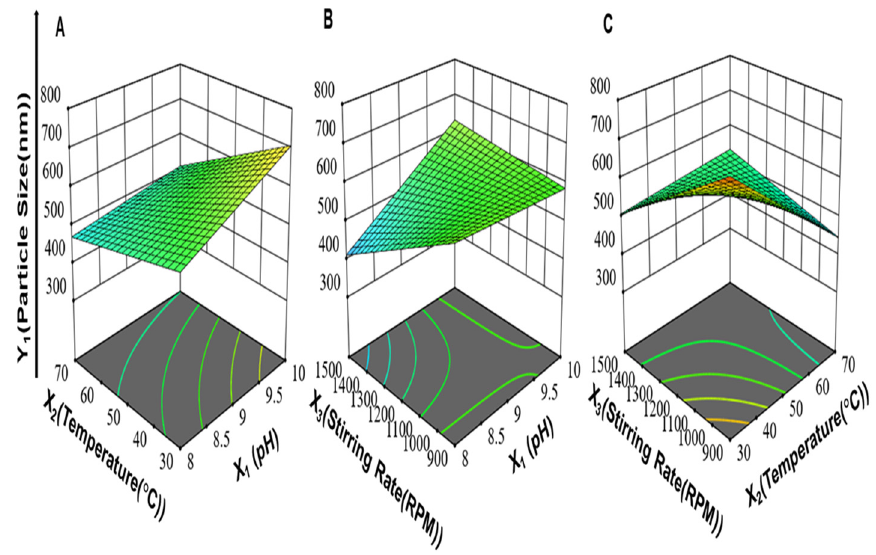
Figure 1. The 3-D response surface plots for ( A ) the interaction between pH and reaction tempera- ture (X 1 X 2 ), ( B ) the interaction between pH and stirring rate (X 1 X 3 ), ( C ) and the interaction between reaction temperature and stirring rate (X 2 X 3 ) on particle size (Y 1 ) of ZnO-NPs while keeping the third variable at an average value between its high and low levels.